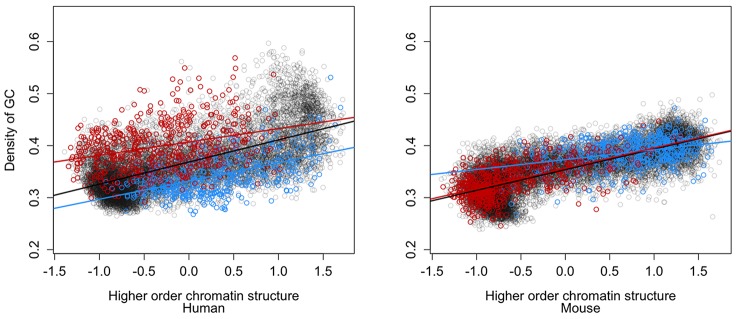
Chromatin divergence and GC content.Percentage of GC nucleotides within all 16,820 100 Kb orthologous regions across the spectrum of mean normalised chromatin structure values. The GC content and higher order structure values for human (left panel) are compared with the GC content and higher order structure values for mouse (right panel). Three classes of regions are shown with their least squares regression lines: nondivergent (grey), divergent open (blue) and divergent closed (red). Note that the bipolar classification of orthologous divergent regions (see text) means that human divergent open regions correspond to mouse divergent closed regions, and vice versa.